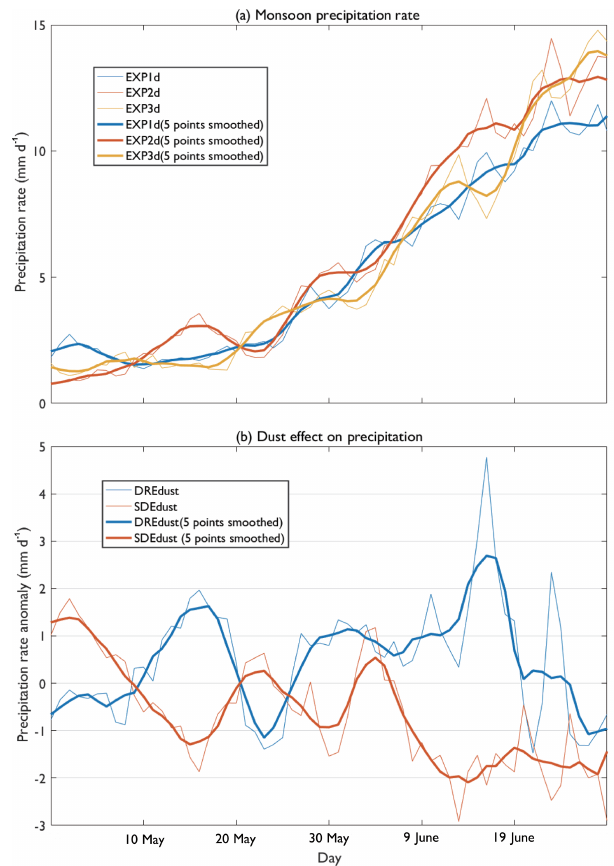
Figure 4. Daily precipitation rates (mmday − 1 ), averaged for mon- soon area (10–25 ◦ N, 65–100 ◦ E), during May and June in three experiments (a) , and the differences (mmday − 1 ) induced by the snow-darkening effect and direct radiative effect of dust (b) . Thin lines show the daily values and thick ones are 5-day smoothed. In (b) , red lines donate the snow-darkening effect and blue lines donate the direct radiative